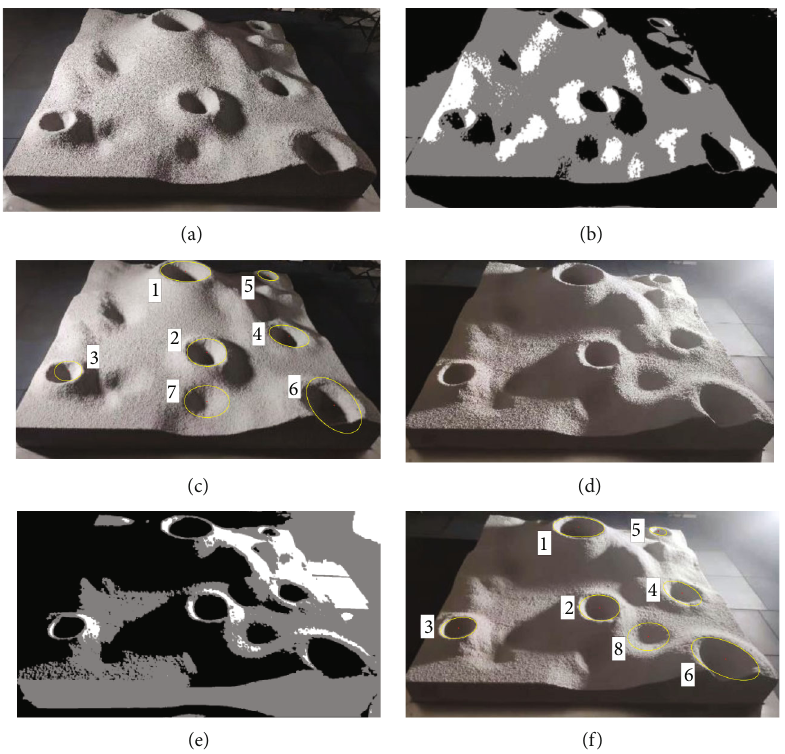
Figure 10: Detection results under di ff erent illumination directions. Table 3: Image information and PC parameters. Image information PC parameter Image size Image resolution CPU RAM 9638 × 12472 7m Intel i9-10900